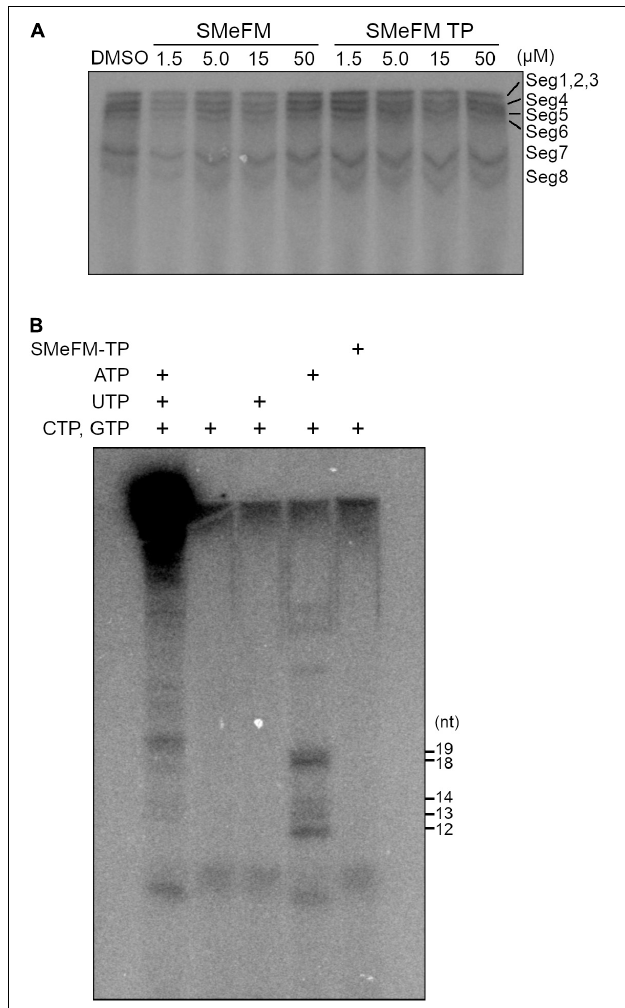
FIGURE 7 | SMeFM triphosphate is not incorporated into synthesized RNA. (A) In vitro RNA synthesis from vRNPs with SMeFM and SMeFM triphosphate (SMeFM TP). In vitro RNA synthesis assay was performed with SMeFM or SMeFM TP at 30 ◦ C for 30 min. Synthesized RNAs were separated by UREA-PAGE. (B) Limited elongation assay with SMeFM TP. In vitro RNA synthesis assay was performed with or without UTP, ATP, or SMeFM. Synthesized RNAs were separated by UREA-PAGE. The expected lengths of limited elongation products without UTP were 12 nt for segments 1, 3, and 7, 13 nt for segment 5, 14 nt for segment 6, 18 nt for segment 4, and 19 nt for segment